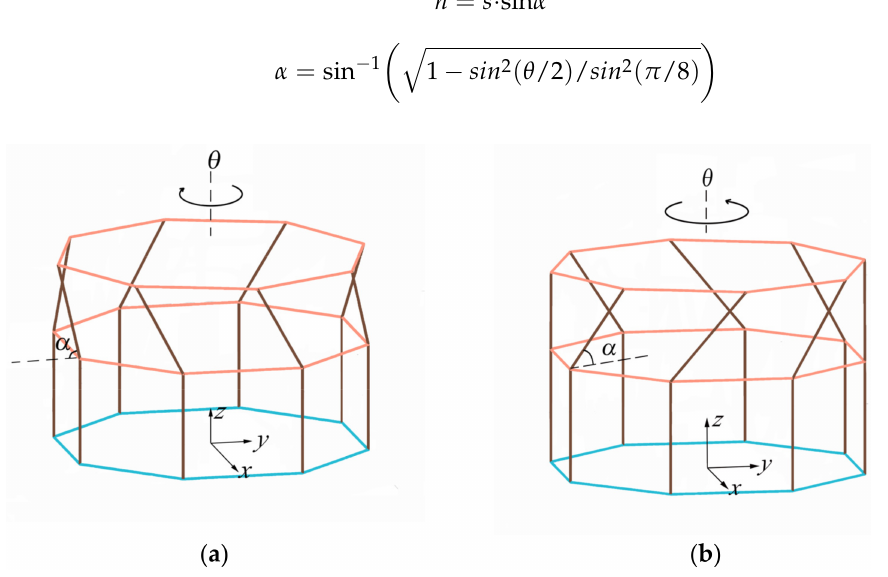
Figure 5. Definition of offset angle α : ( a ) clockwise twisting; ( b ) counterclockwise